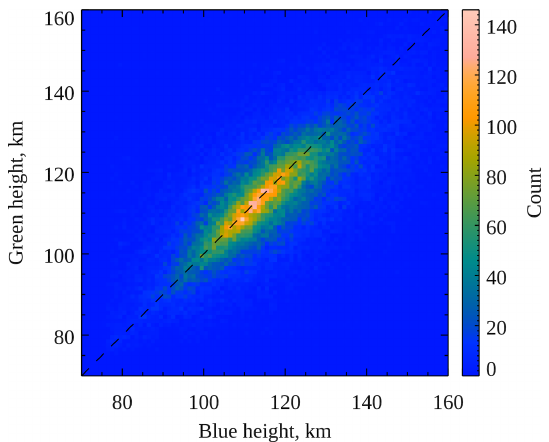
Figure 3. Two-dimensional histogram of simultaneous green (557.7nm) and blue (427.8nm) peak emission heights. The shading represents the number of observations in each histogram bin, ac- cording to the colour bar scale shown on the right of the figure. The dashed black line indicates where the two peak emission heights are equal.